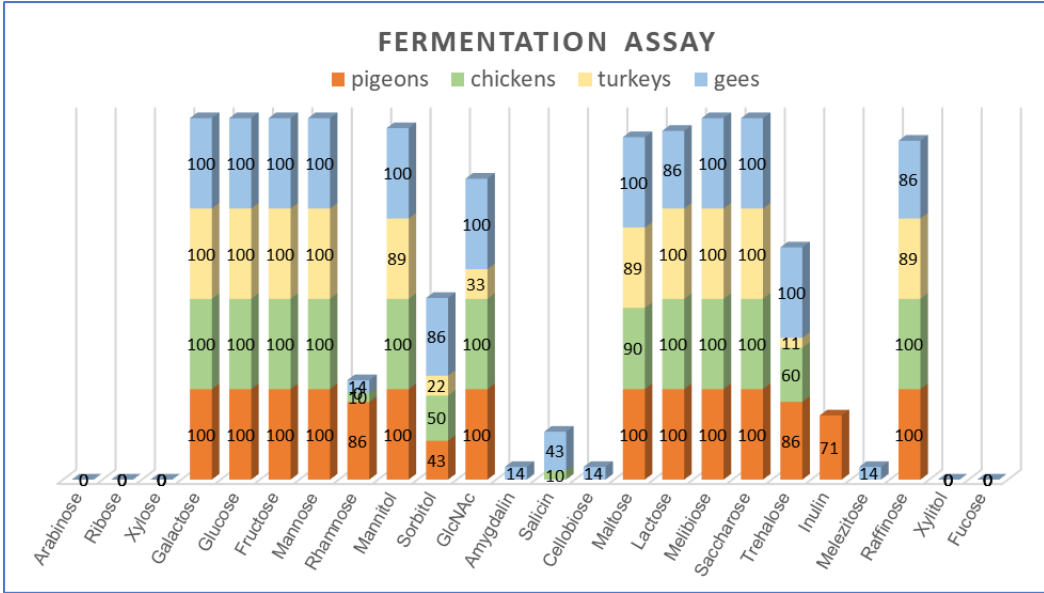
Figure 4. Percentage of L. salivarius strains capable of utilizing individual carbohydrates.